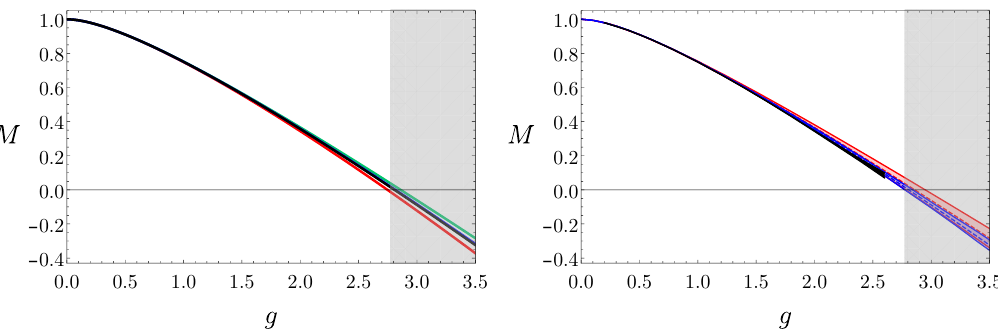
Figure 7 . (Left panel) The physical mass M as a function of the coupling constant g using conformal mapping at di(cid:11)erent orders: N = 5 (red line), N = 6 (green line), N = 7 (blue line), N = 8 (black line). Errors are not reported to avoid clutter. The N = 7 and N = 8 lines are indistinguishable. (Right panel) Comparison between the results obtained using conformal mapping at L = 8 (light blue), Pad(cid:19)e-Borel approximants (light red) and the results of ref. [14]